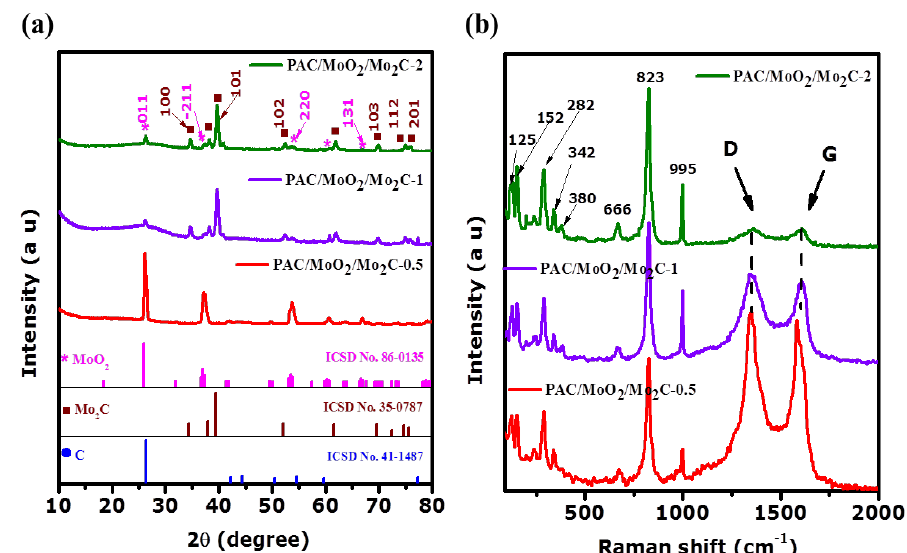
Figure 2. ( a ) XRD patterns and ( b ) Raman spectra of the PAC/MoO 2 /Mo 2 C-0.5, PAC/MoO 2 /Mo 2 C-1 and PAC/MoO 2 /Mo 2 C-2.